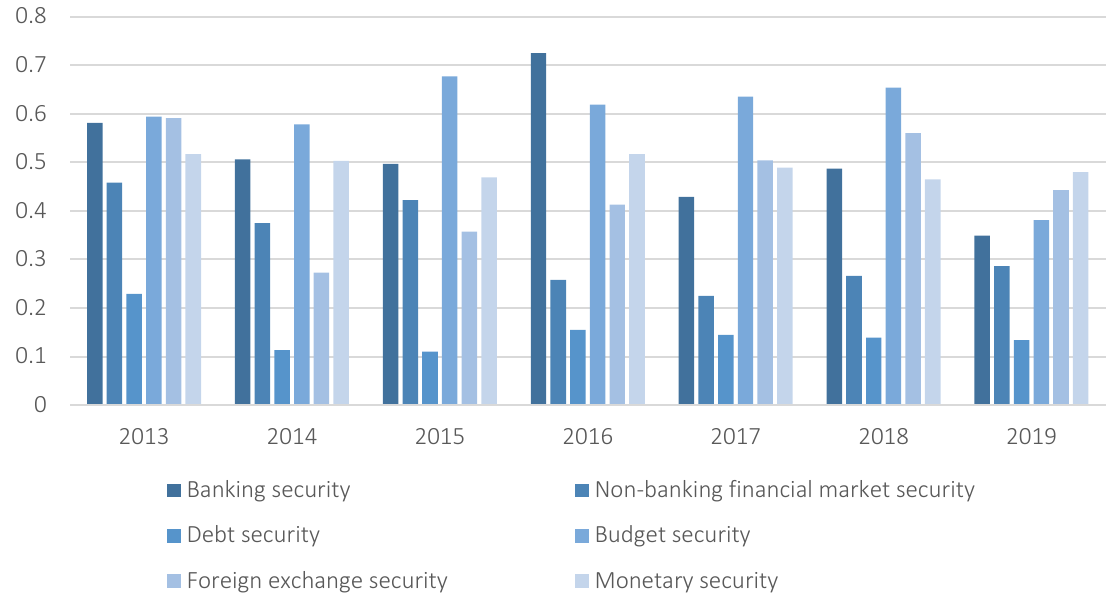
Figure 2. Dynamics of changes in the components of Ukraine’s financial security for 2013–2019